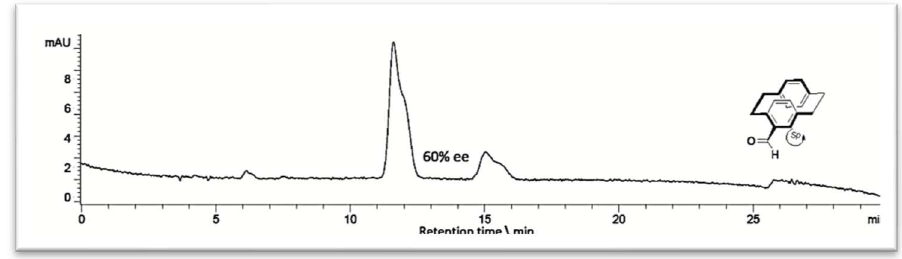
Figure 4. Analytical HPLC of 60% ee- 8.